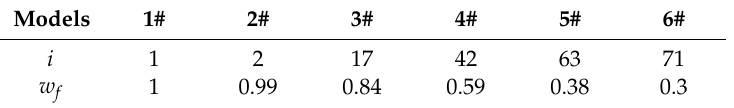
Table 4. The result of operating points selection based on the gap metric